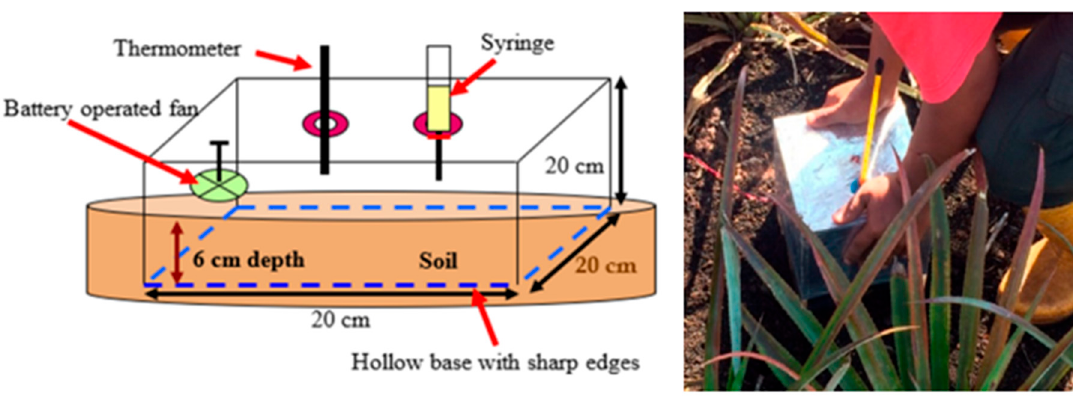
Figure 4. A closed chamber system to estimate soil methane emission from tropical peatland .